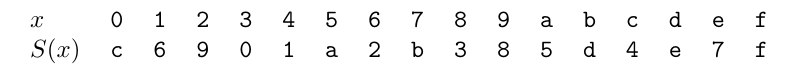
Table 2: The 4-bit S-box used in Skinny64 in its natural basis representation. x 0 1 2 3 4